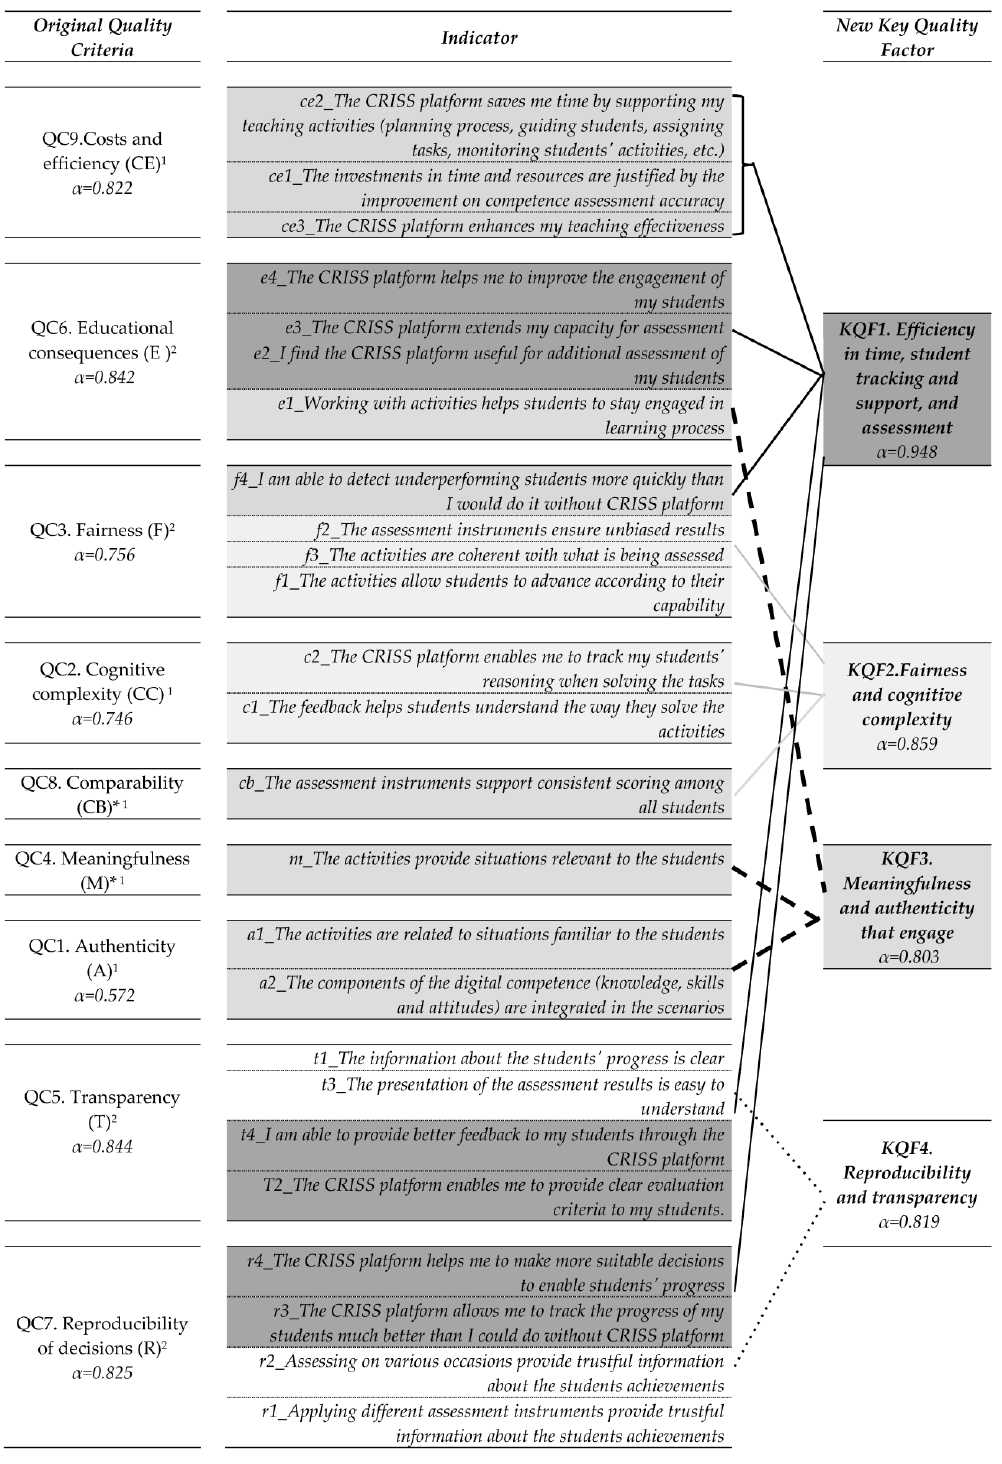
Figure 2. Four Factors of QC of CAMs. * Cronbach’s alpha ( α ) not calculable. 1 Not divided criteria. 2 Divided